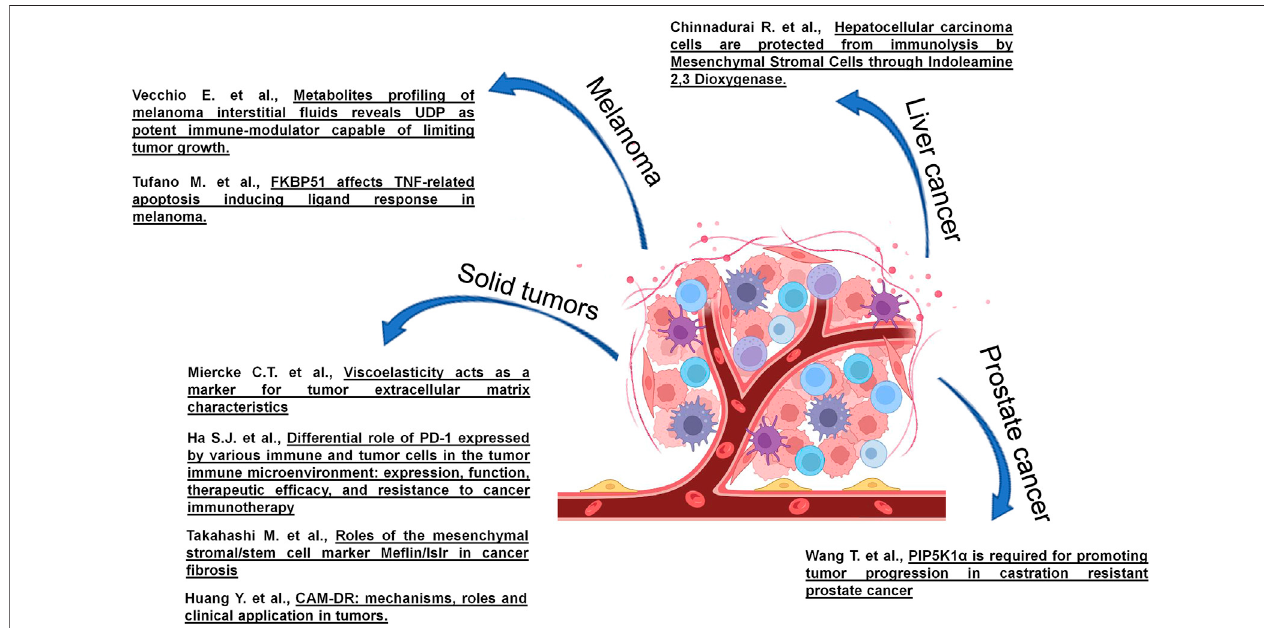
FIGURE 1 | Studies on TME of different cancers published in the research topic entitled “ Tumor Microenvironment and Cancer Cell Interactions in Solid Tumor Growth and Therapy Resistance.